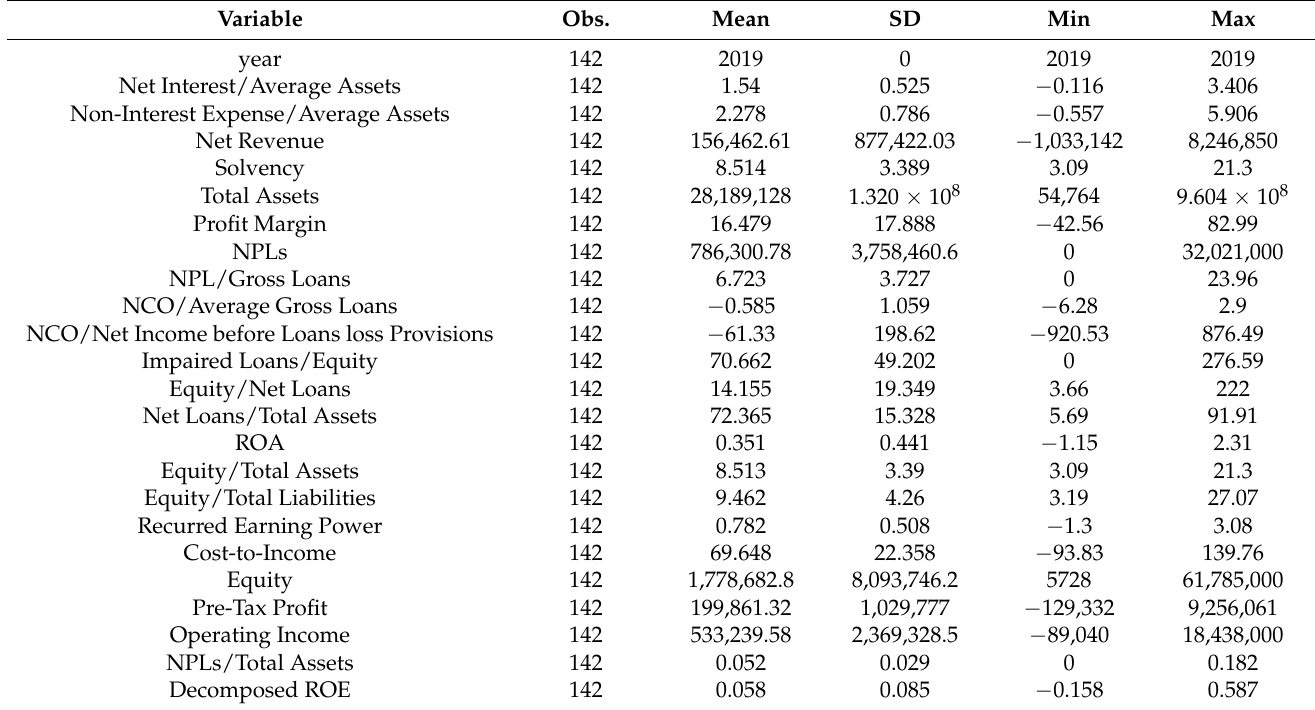
Table A9. Descriptive statistics for the 142 Italian banks for the year 2019.